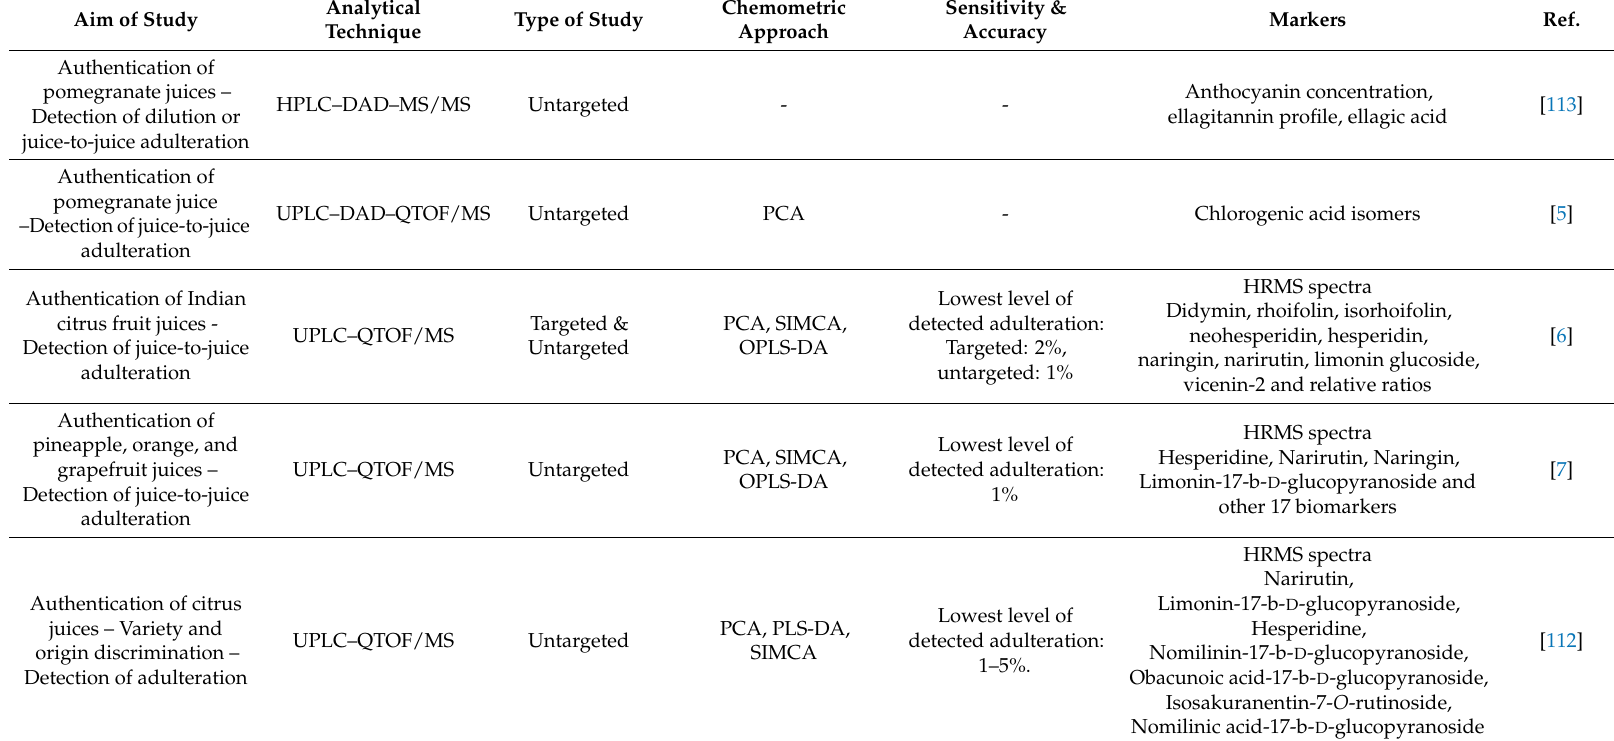
Table 6. Applications of untargeted authenticity studies of fruit